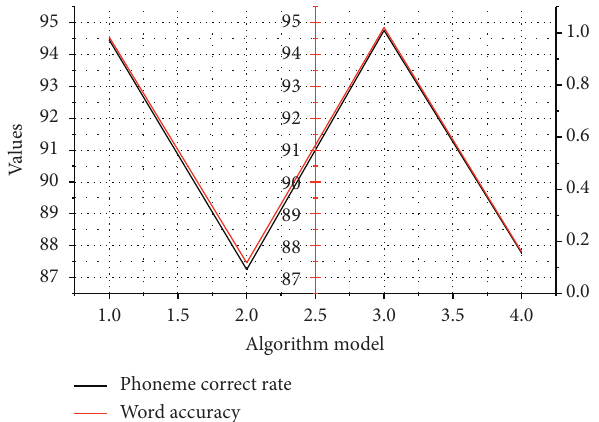
Figure 8: Performance comparison between pretraining and